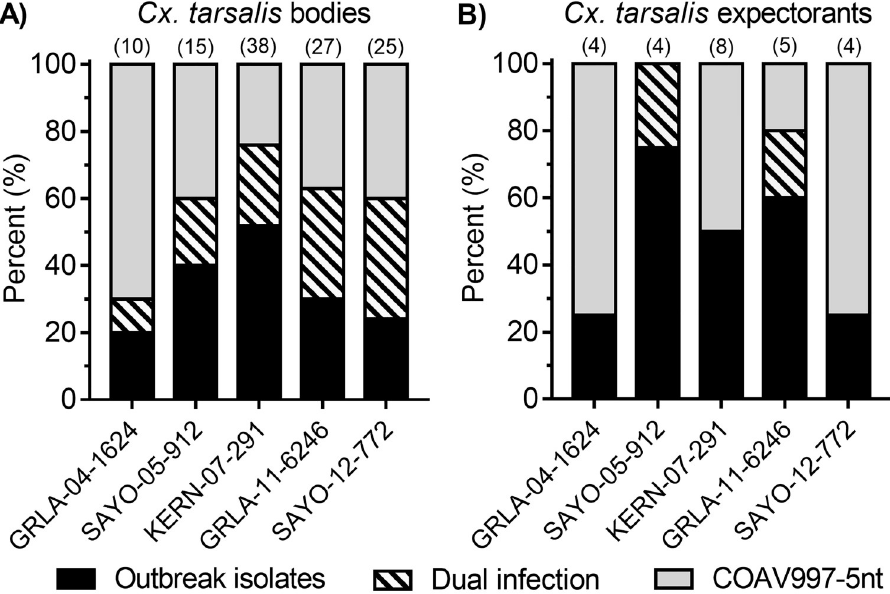
Fig 1. Percentage of Culex tarsalis bodies (A) and expectorants (B) positive for each outbreak isolate and/or COAV997-5nt viral RNA following competition. Cx . tarsalis bodies and cell-culture amplified expectorants were analyzed by concurrent qRT-PCR for the presence of viral RNA. Columns indicate the percentage of infected mosquitoes containing RNA for either the outbreak isolate (black color), COAV997-5nt (grey color) or both virus strains (grey with black stripes) within each competition group. The number of samples positive within each competition group was included in parentheses at the top of each column.